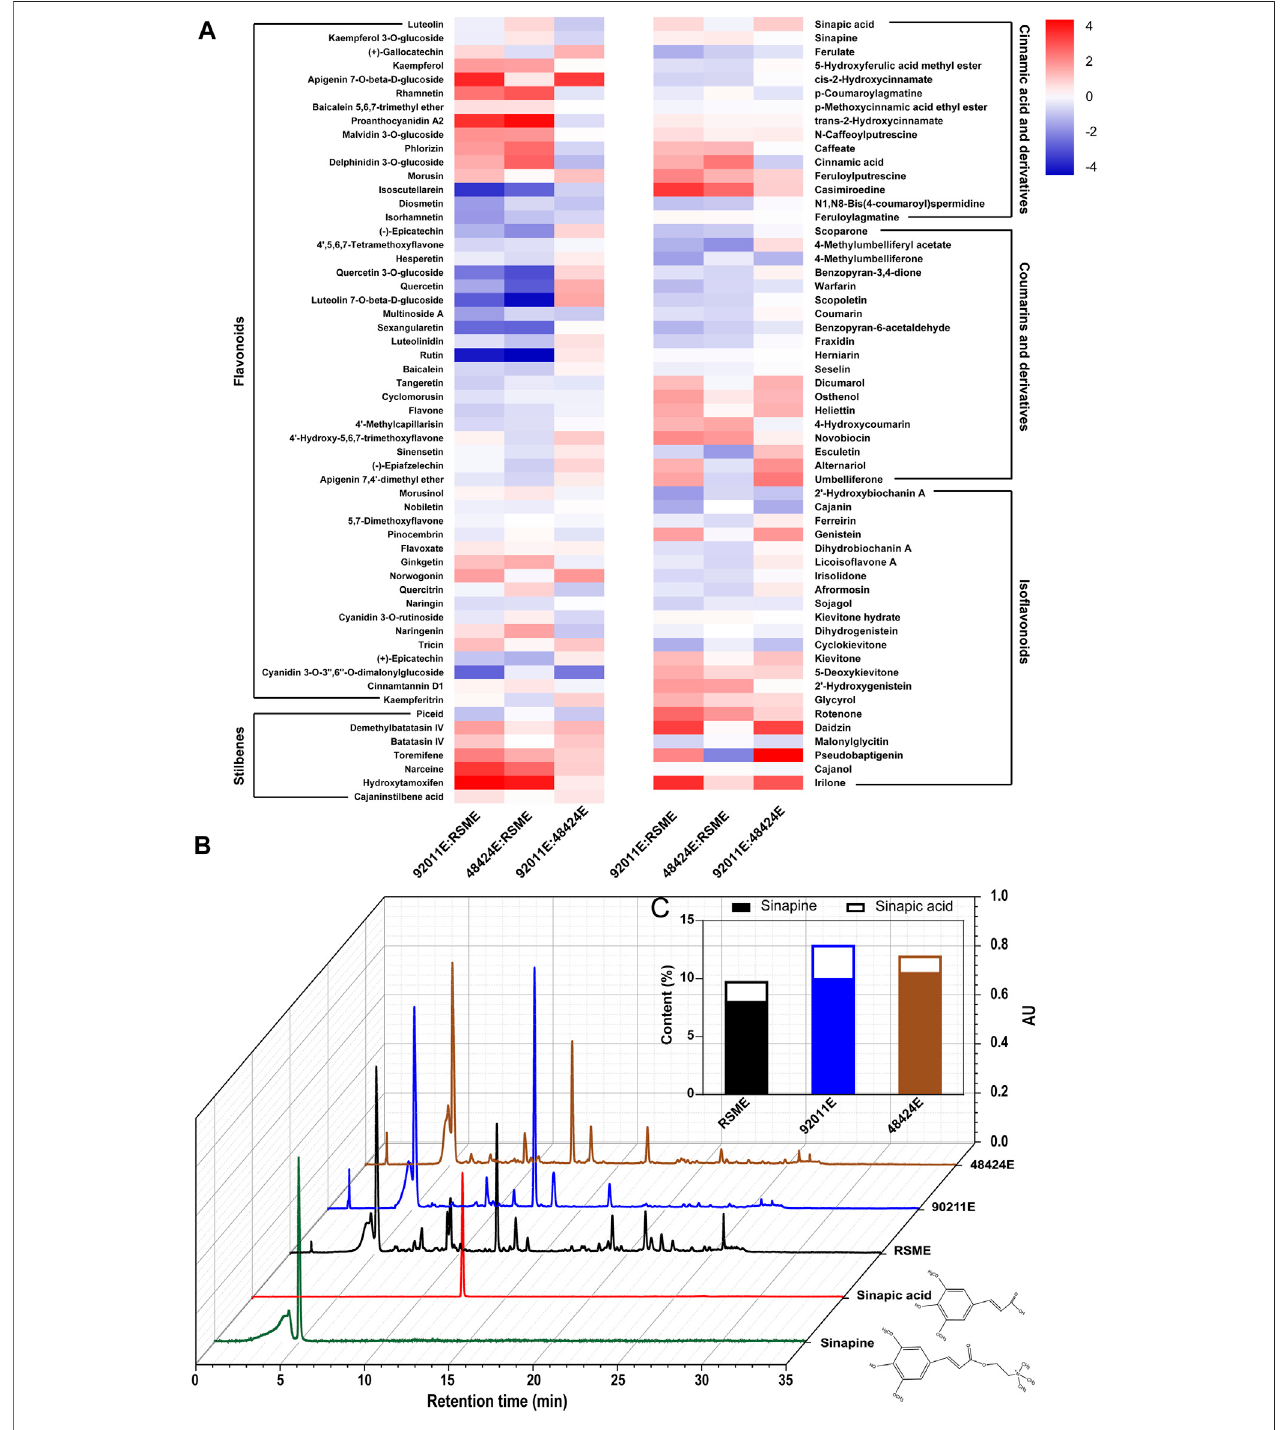
FIGURE2| Effectsoffungalpretreatment onphenolicpro fi le.Heatmapsofphenolicpro fi ledifferencesamongthreephenoliccompoundextracts (A) ,comparison of the UPLC chromatograms of three phenolic extracts (B) and sinapic acid and sinapine contents in three bioactive compound extracts (C) .